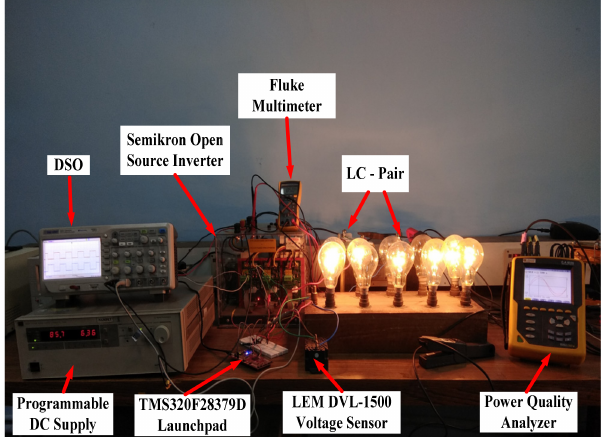
Figure 11. Experimental setup.